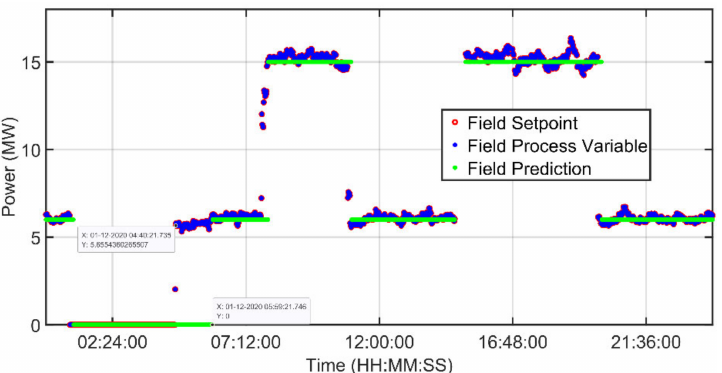
Figure 11. Data analysis results: electric energy production plan and real production.